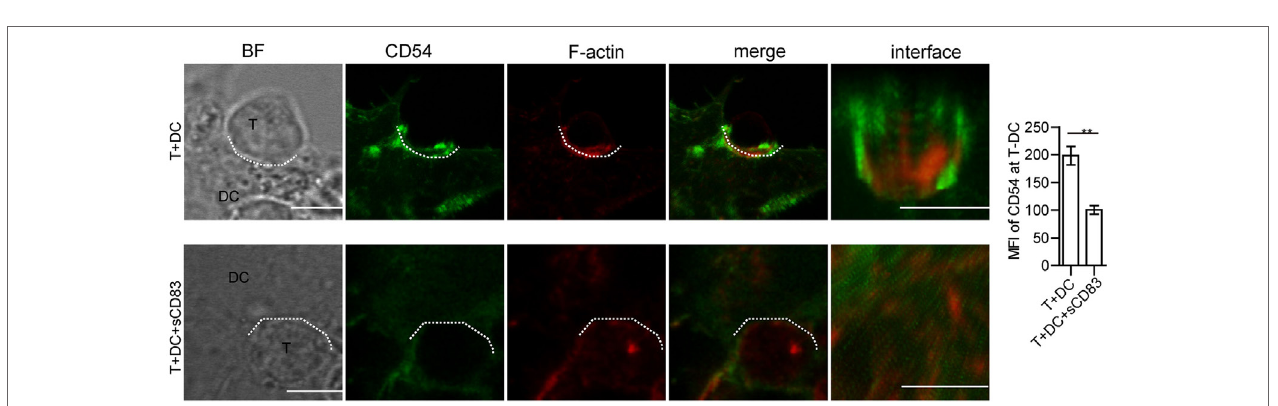
FigUre 8 | Soluble CD83 (sCD83) affects the accumulation of CD54 at the contact zone of dendritic cell (DC) and T cells. The localization of CD54 (green) and filamentous actin (F-actin) (red) at the DCs–T contact zone was analyzed by confocal microscopy with untreated (top row) or sCD83-treated DC2.4 (bottom row). The dotted lines mark the DCs–T synapse. Scale bar = 5 µm. Mean ± SEM n = 15 for every group from three independent experiments, two-tailed Student’s t -test. ** p < 0.01.